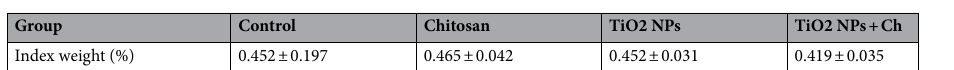
Table 1. Effect of TiO 2 NPs/Chitosan on testicular index weight. Data are represented as mean ± SEM.